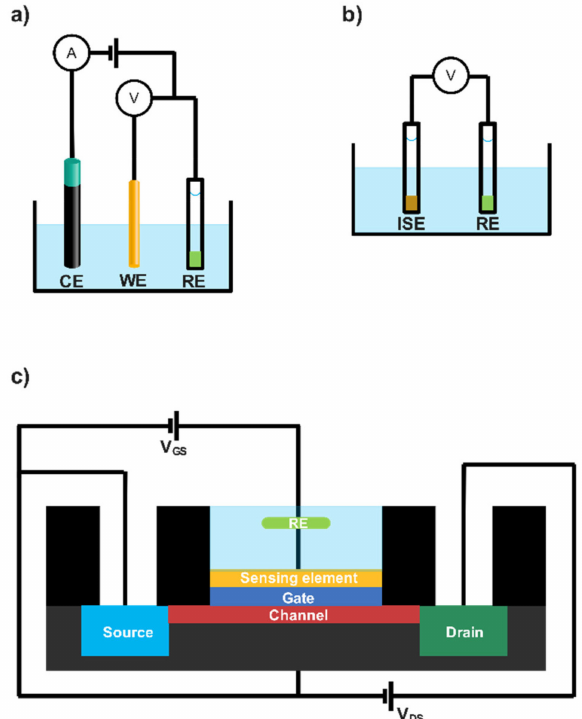
Figure 2. Scheme of main transduction mechanisms for lactate electrochemical (bio)sensors: ampero- metric ( a ); voltammetric ( b ) and field-effect transistor ( c